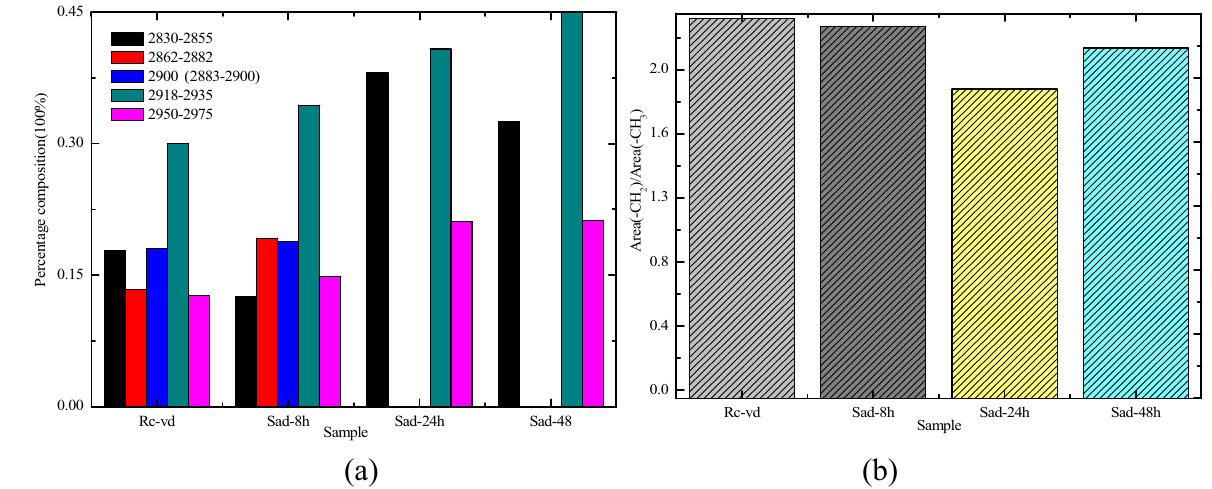
Figure 6. Content distribution of various functional groups for the 2800–3000 cm −1 band and asym.CH 2 /asym. CH 3 . ( a ) Percentages of different functional groups ( b ) asym.CH 2 /asym.CH 3 .